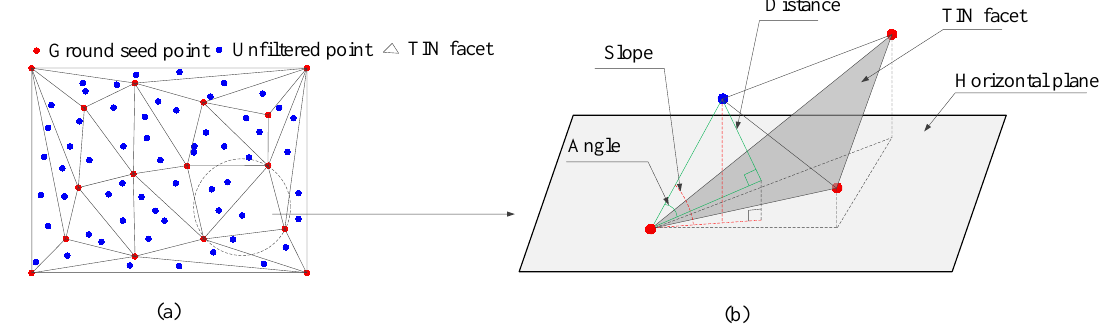
Figure 9. Key parameters in PTD. ( a ) Initial provisional DTM, ( b ) key parameters.